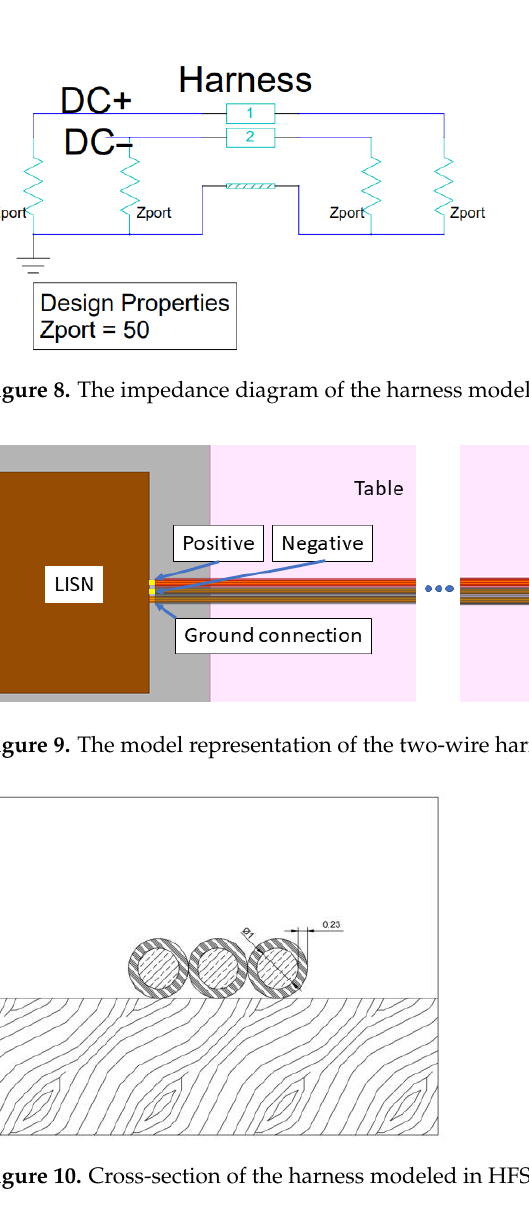
Figure 10. Cross-section of the harness modeled in HFSS tool.